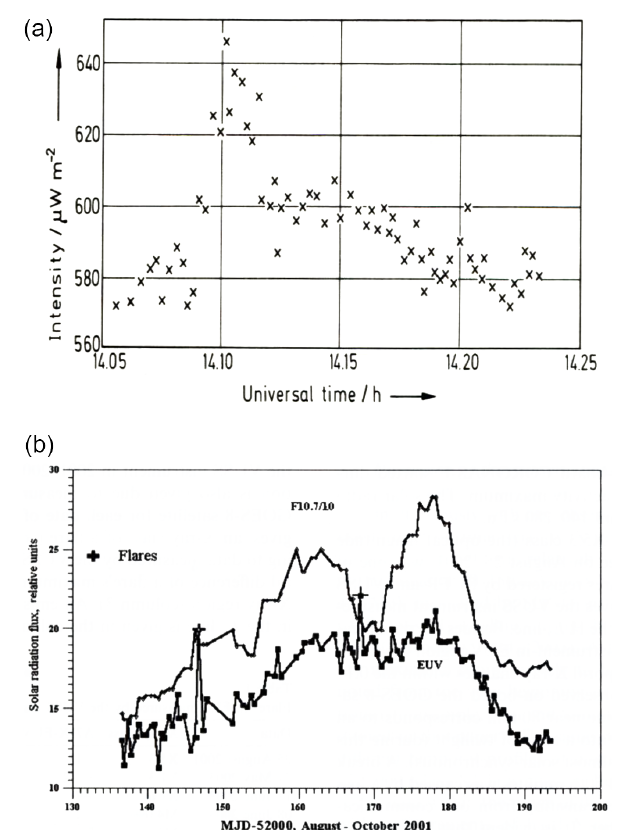
Figure 18. (a) Solar rotation variability of selected emissions (Hall and Hinteregger, 1970; copyright permission granted by Wiley pub- lishing). From top to down: He II at 30.4nm; C III at 97.7nm; H I at 102. 5nm; O VI at 103.2nm; O V at 63.0nm; He I at 58.4nm; Fe XVI at 33.5nm, and below Covington index ( F 10 . 7 ) . (b) EUV flux and Covington index ( F 10 . 7 ) variability with solar rotation (Nusi- nov et al., 2006; copyright permission granted by Elsevier publish- ing).